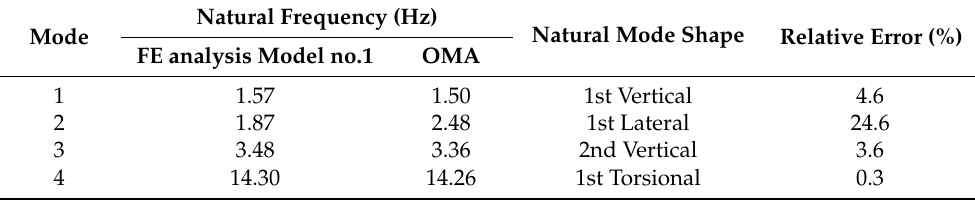
Table 2. Comparison of experimentally measured and preliminary calculated natural frequencies and description of mode